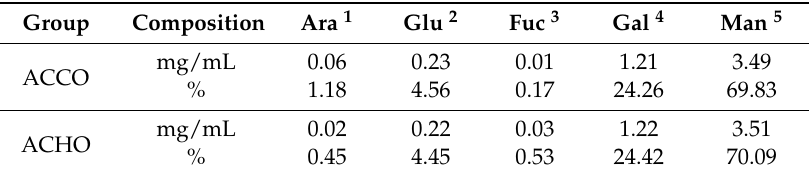
Table 2. Monosaccharide composition of ACCO and ACHO. Group